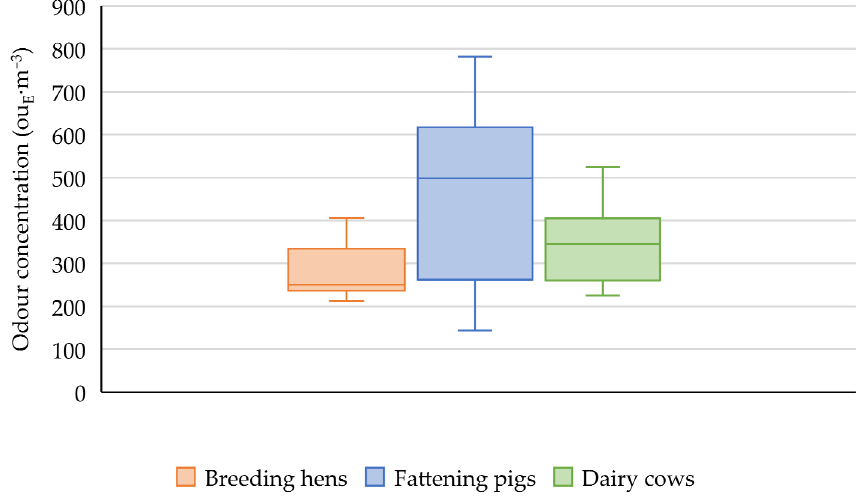
Figure 13. Odour Figure 13. Odour concentration.